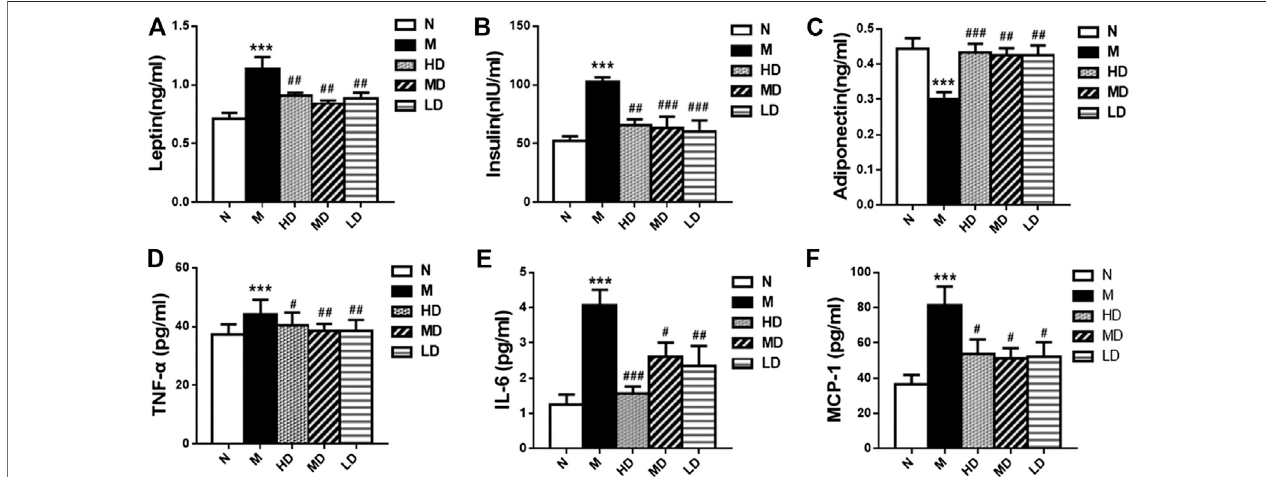
FIGURE 2 | Effects of CQR on serum biochemical parameters in rats fed with high fat diet. (A) Leptin; (B) insulin; (C) adiponectin; (D) TNF- α ; (E) IL-6; (F) MCP-1. Data are expressed as mean ± SEM ( n (cid:1) 10). * p < 0.05, ** p < 0.01, *** p < 0.001, vs N group; # p < 0.05, ## p < 0.01, ### p < 0.001, vs M group.